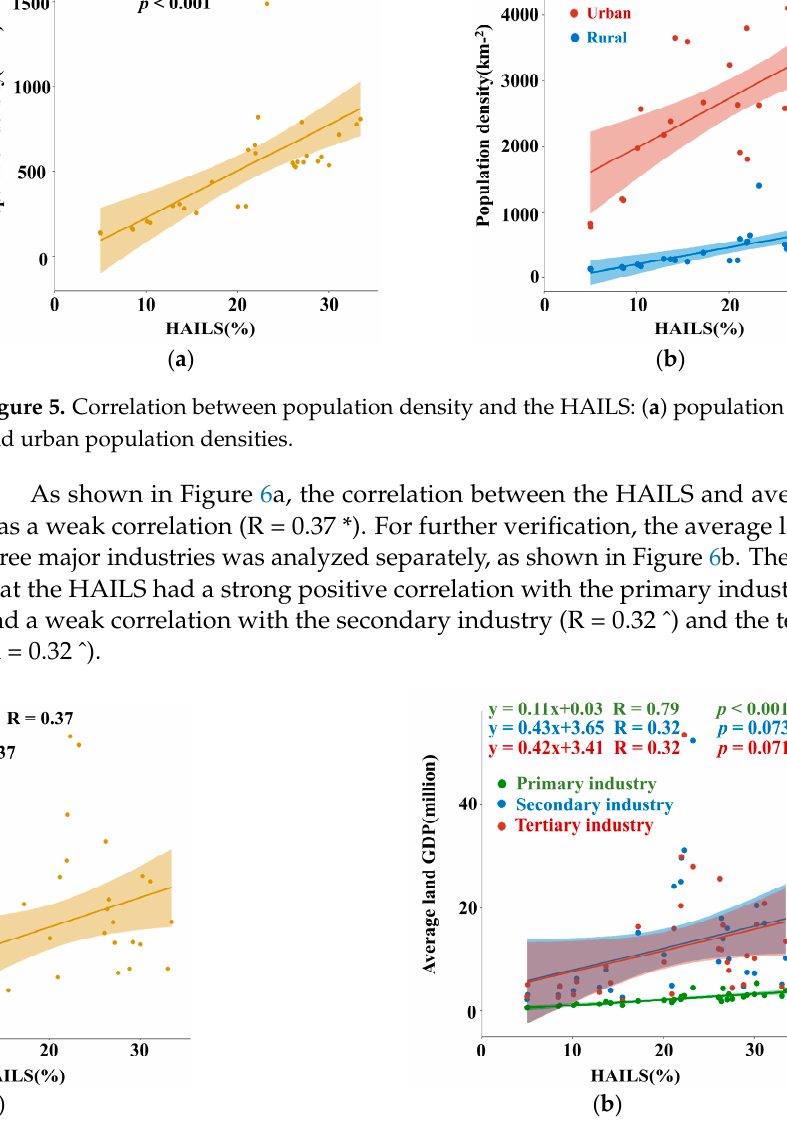
Figure 7. Correlation between average land GDP of primary industry, secondary industry, as well as tertiary industry and the HAILS without Hefei and Tongling.